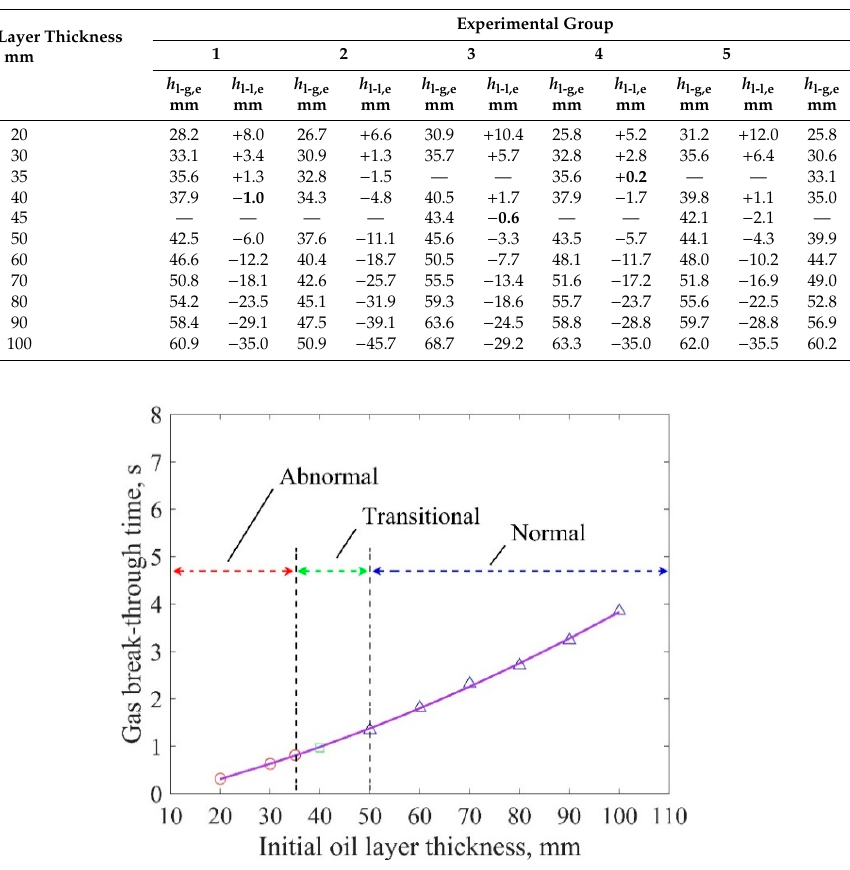
Table 3. Levels of horizontal parts of the interfaces at the end of drainage under di ff erent experimental conditions (cf. Table 2). Values that fall in the transition zone have been indicated by bold values, and lack of experimental results by an em dash (—).